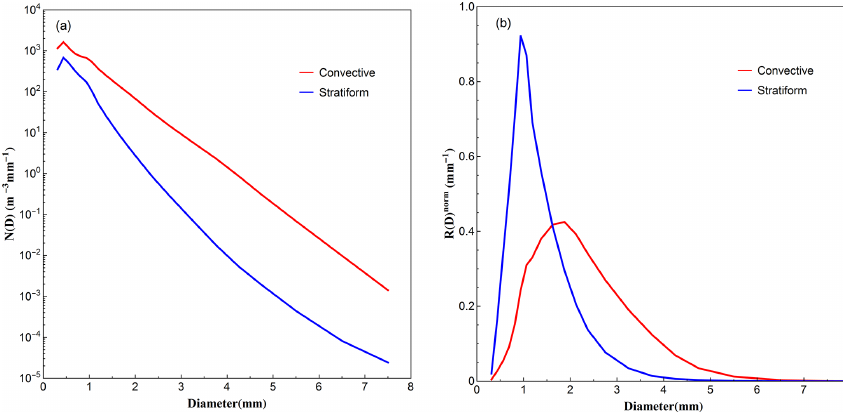
Figure 6. Composite raindrop spectra (a) and normalized R(D) distributions (b) for different rain types.